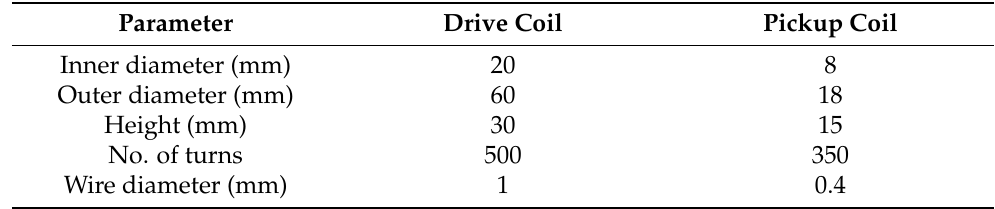
Table 2. Probe coil parameters.